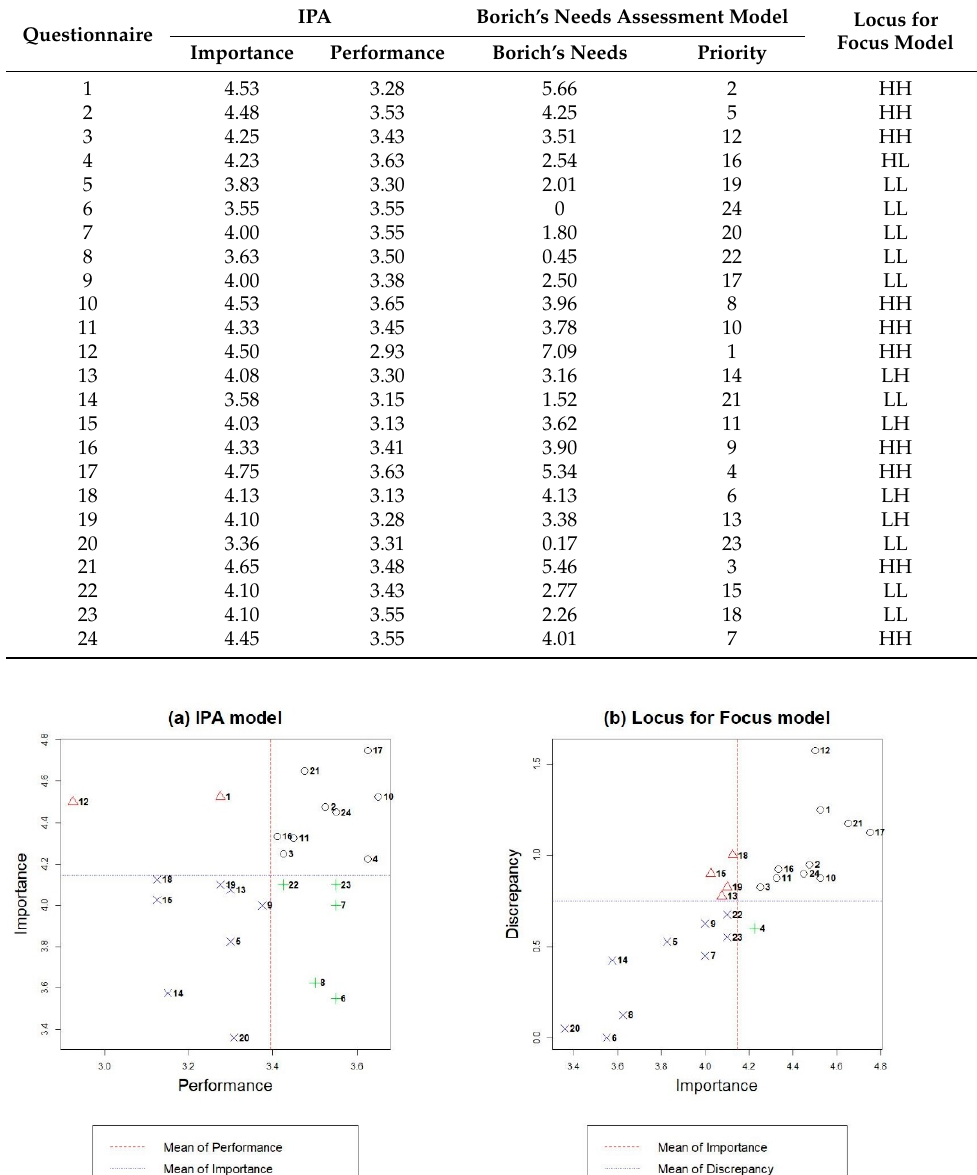
Table 4. IPA, Borich’s needs assessment, and locus for focus models for Costa Concordia Case 1 (from an accident investigation report and the provided articles).